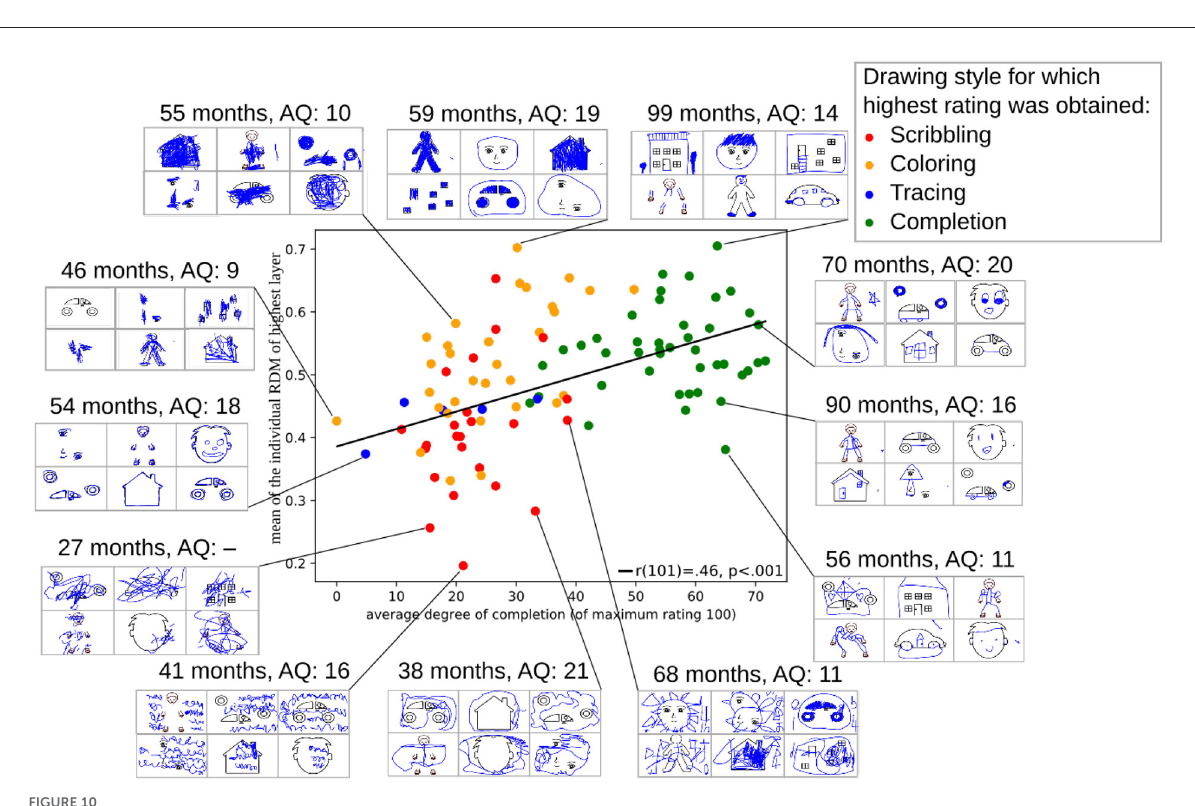
FIGURE10 An exemplary score computed from the RDM matrices of all children (y-axis), plotted against the completion score acquired in the rating analysis (x-axis), including some examples of children’s drawings. Here, the score is computed as the average of the RDM matrix of the highest layer of the